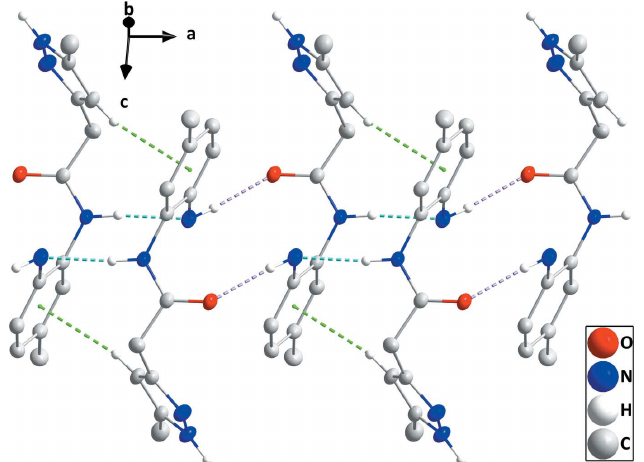
Figure 2 A portion of one chain projected onto (011) with N—H (cid:2)(cid:2)(cid:2) O and N— H (cid:2)(cid:2)(cid:2) N hydrogen bonds depicted, respectively, by light-purple and light- blue dashed lines. The C—H (cid:2)(cid:2)(cid:2) (cid:2) (ring) interactions are depicted by green dashed lines. Hydrogen atoms not involved in interactions have been omitted for